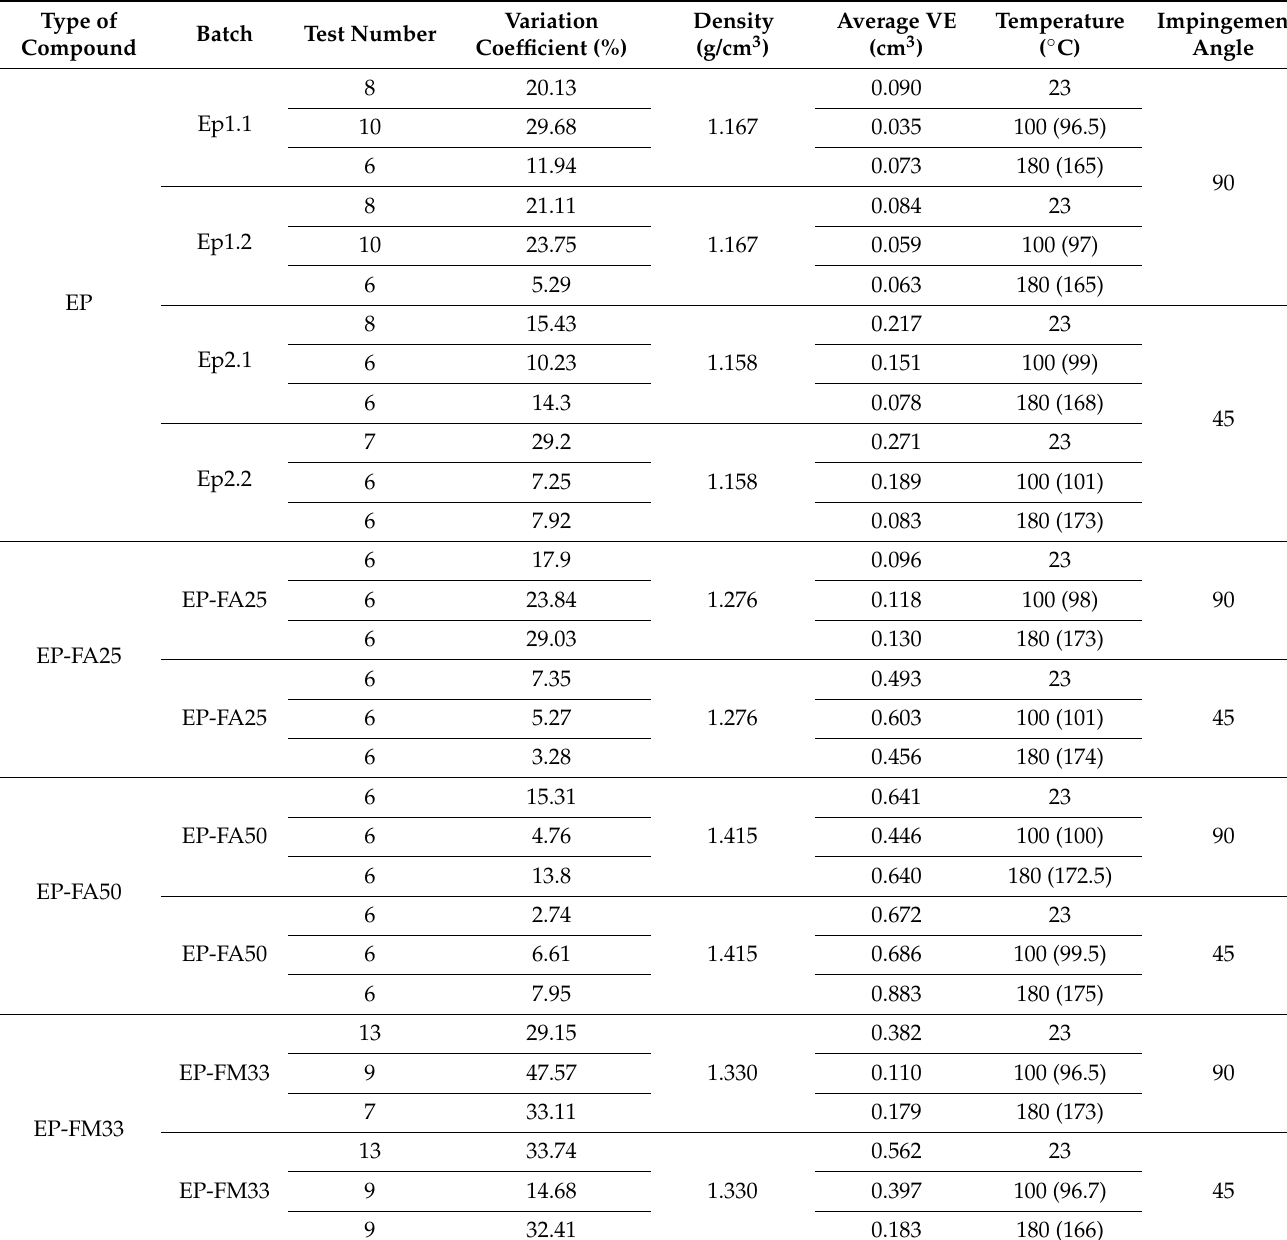
Table 2. Summary table of unfilled epoxy binder (EP) wear test